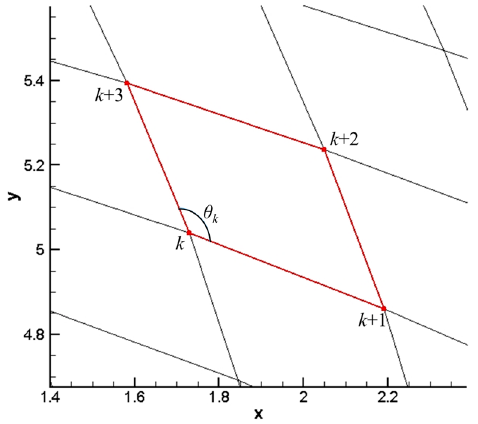
Figure 4. Specific element with minimal metrics.